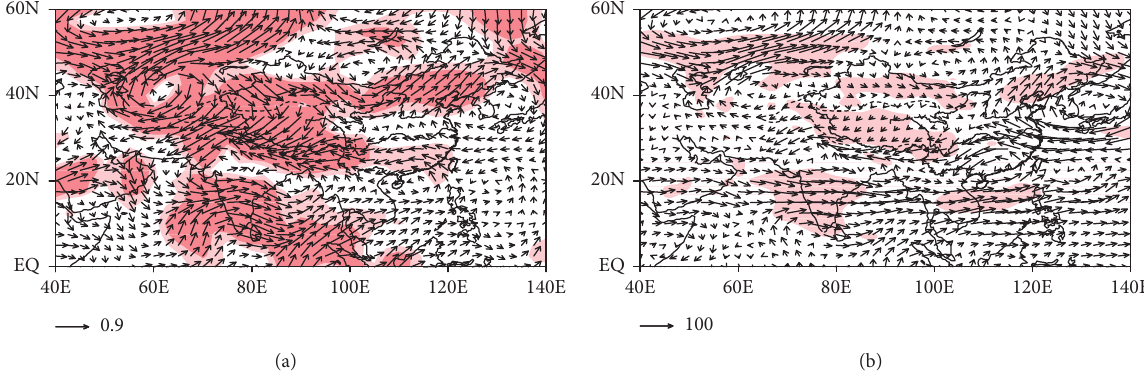
Figure 11: (a) Simultaneous correlation between I W and vertically integrated water vapor flux. (b) Composite anomalies of the water vapor fluxes between the high- I W and low- I W years (unit: g · (s · cm) − 1 ). The dark (light) shading in (a) indicates the correlation coefficients significant at the 99% (95%) confidence level. The shading in (b) indicates the water vapor flux anomalies significant at the 95% confidence level.